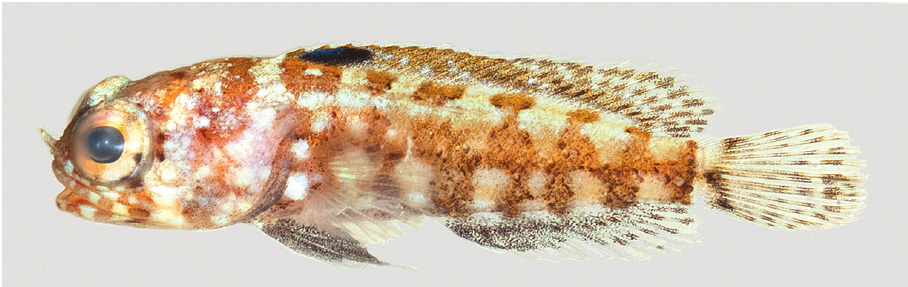
Figure 10. Opistognathus whitehursti , USNM 396062, 22.0 mm SL, Saba Bank. Photograph by Jeffrey T.